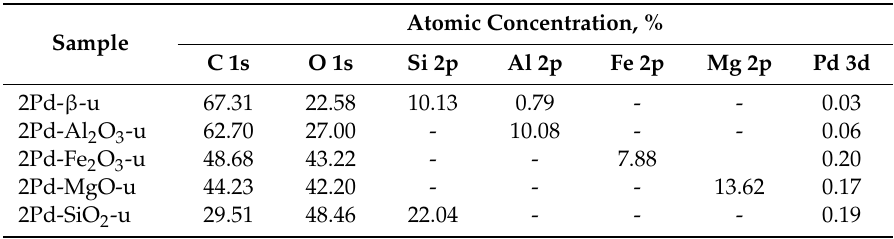
Table 4. Atomic concentration data, obtained from XPS, for Pd-based catalysts (Pd content: 2 wt.%) after FUR oxidative condensation reaction. Experimental conditions: temperature: 170 °C, time: 3 h, catalyst loading: 0.05 g, V (ethanol) : 6 mL, amount of base (Na 2 CO 3 ): 0.10 g, V (H 2 O 2 , 30 wt%): 0.5